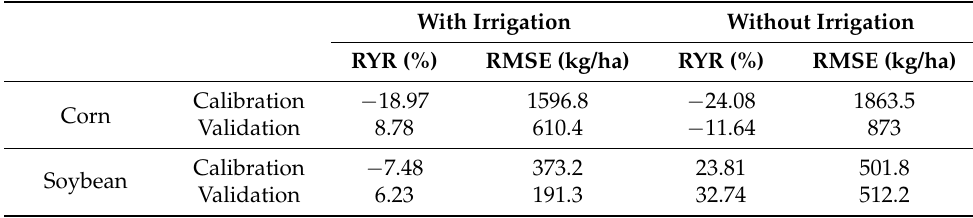
Table 4. Comparison of model performance for crop yield simulations between rainfed and irri- gated conditions.